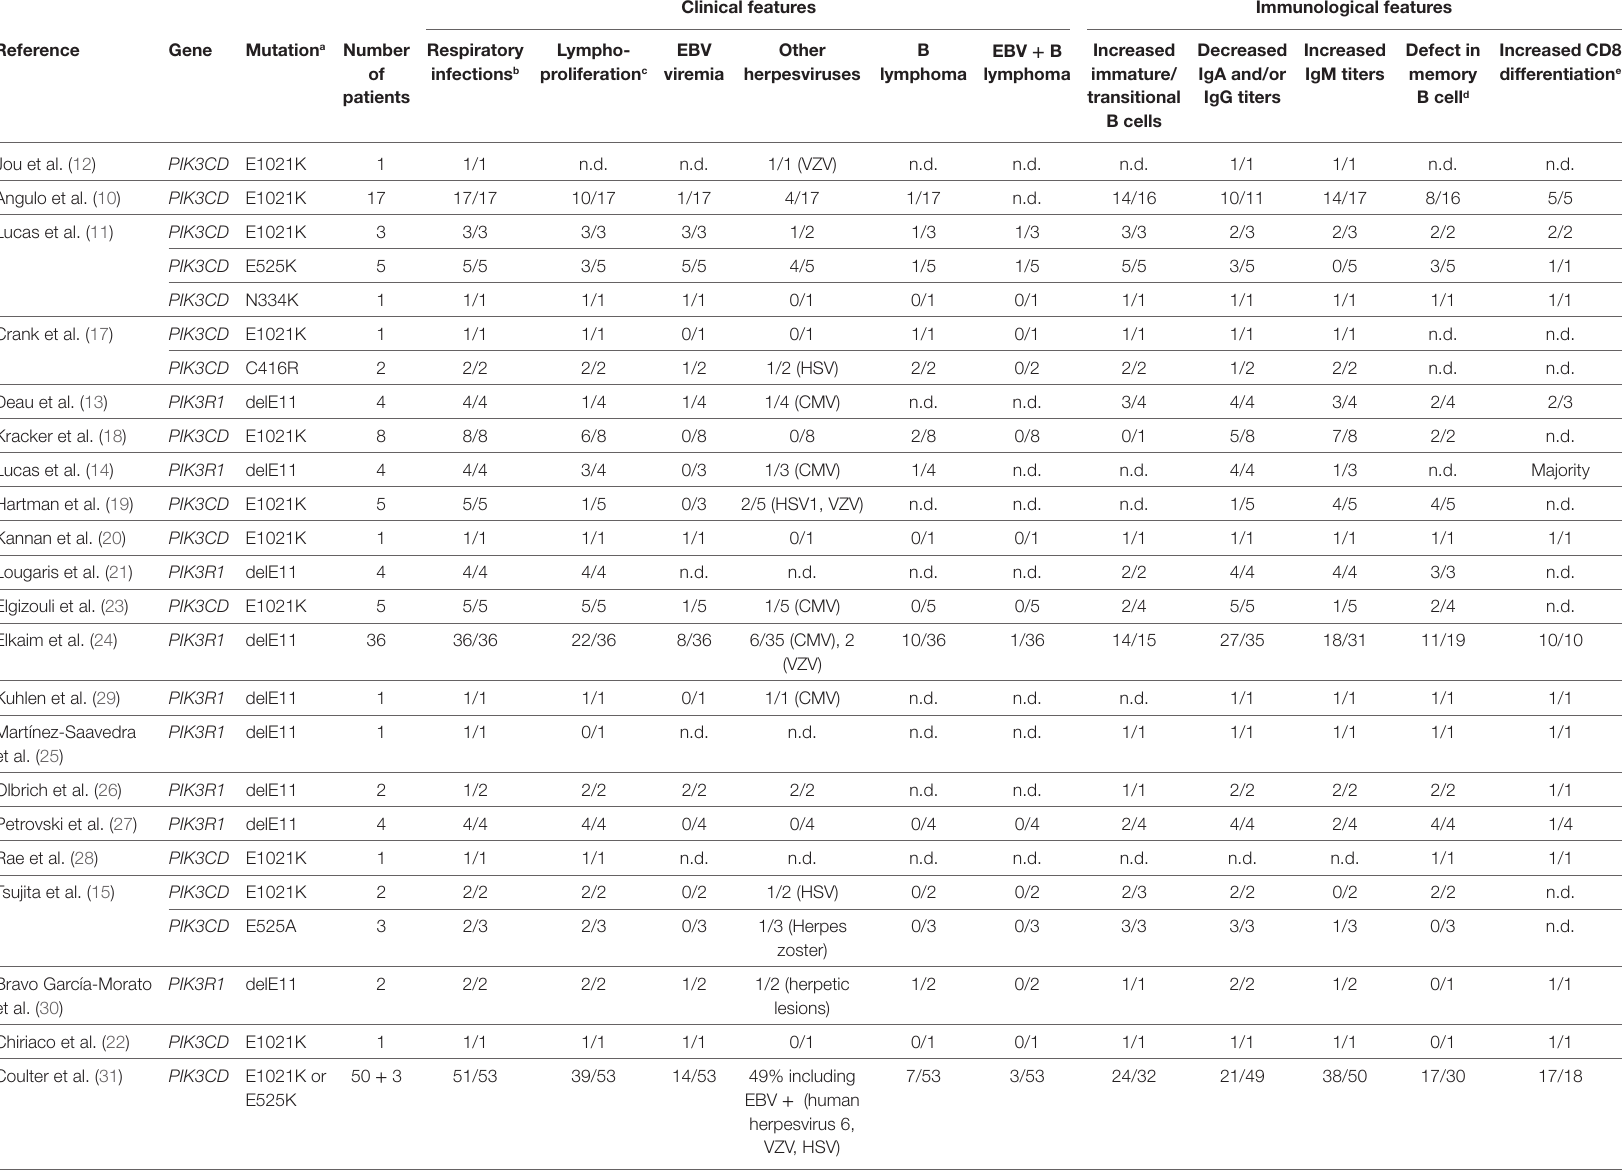
TABLe 1 | Summary of clinical and immunological features of APDS